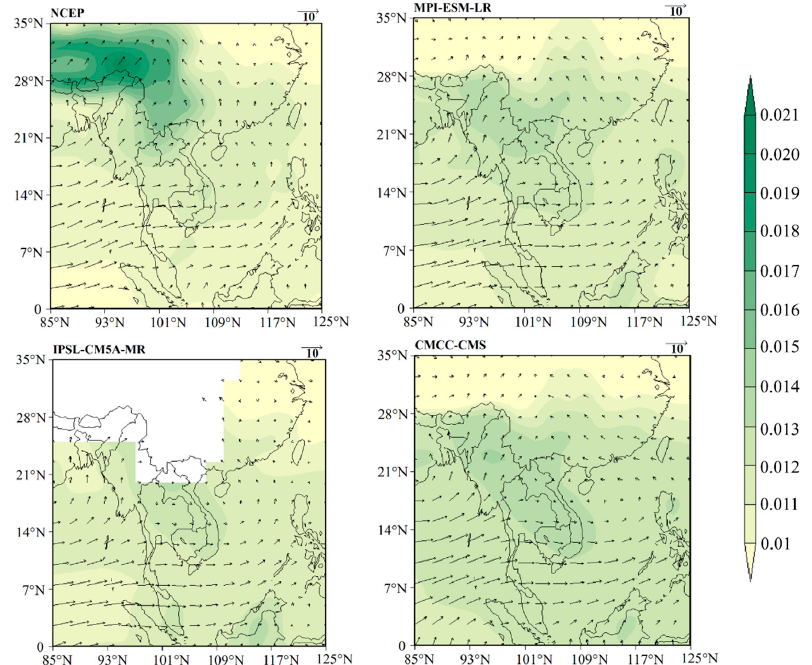
Figure 10. Mean monthly specific humidity (shaded) and wind (vector) for the wet season of the period 1975–2004 for the National Centers for Environmental Prediction (NCEP) and the three best-ranked GCMs over the LMB.